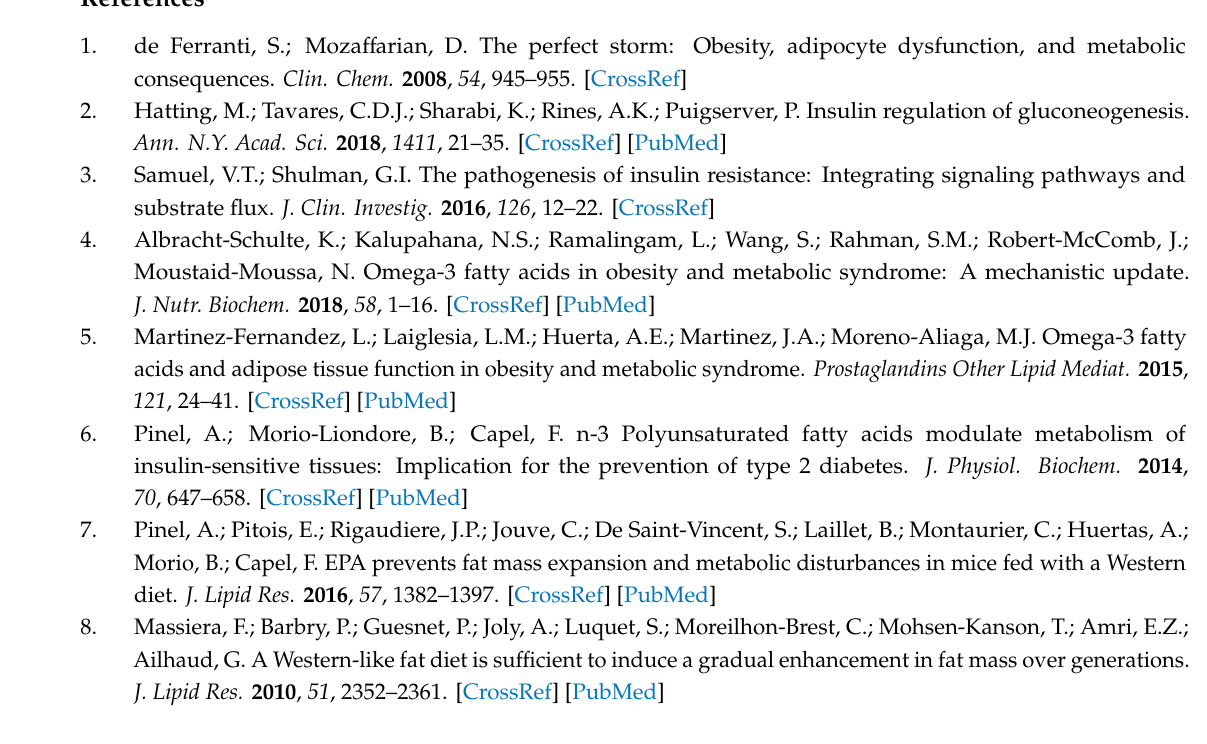
Figure S1: Schematic representation of the dietary intervention, Figure S2: MetExplore pathways representation, Table S1: miRNAs regulating HFepa vs. reference phenotype signature (MMRA Analysis), Table S2: miRNAs regulating HFoleic vs. reference phenotype signature (MMRA Analysis), Table S3: Enriched pathways